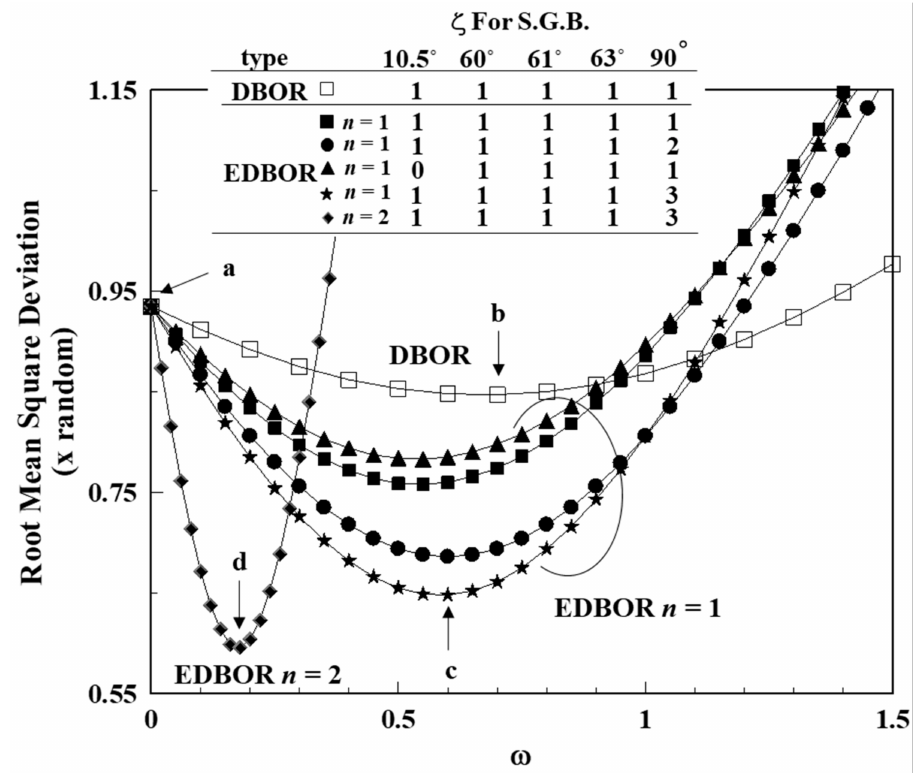
Figure 5. Change in root mean square deviation between observed and predicted ODFs by changing ω and ζ . See inset table for calculation